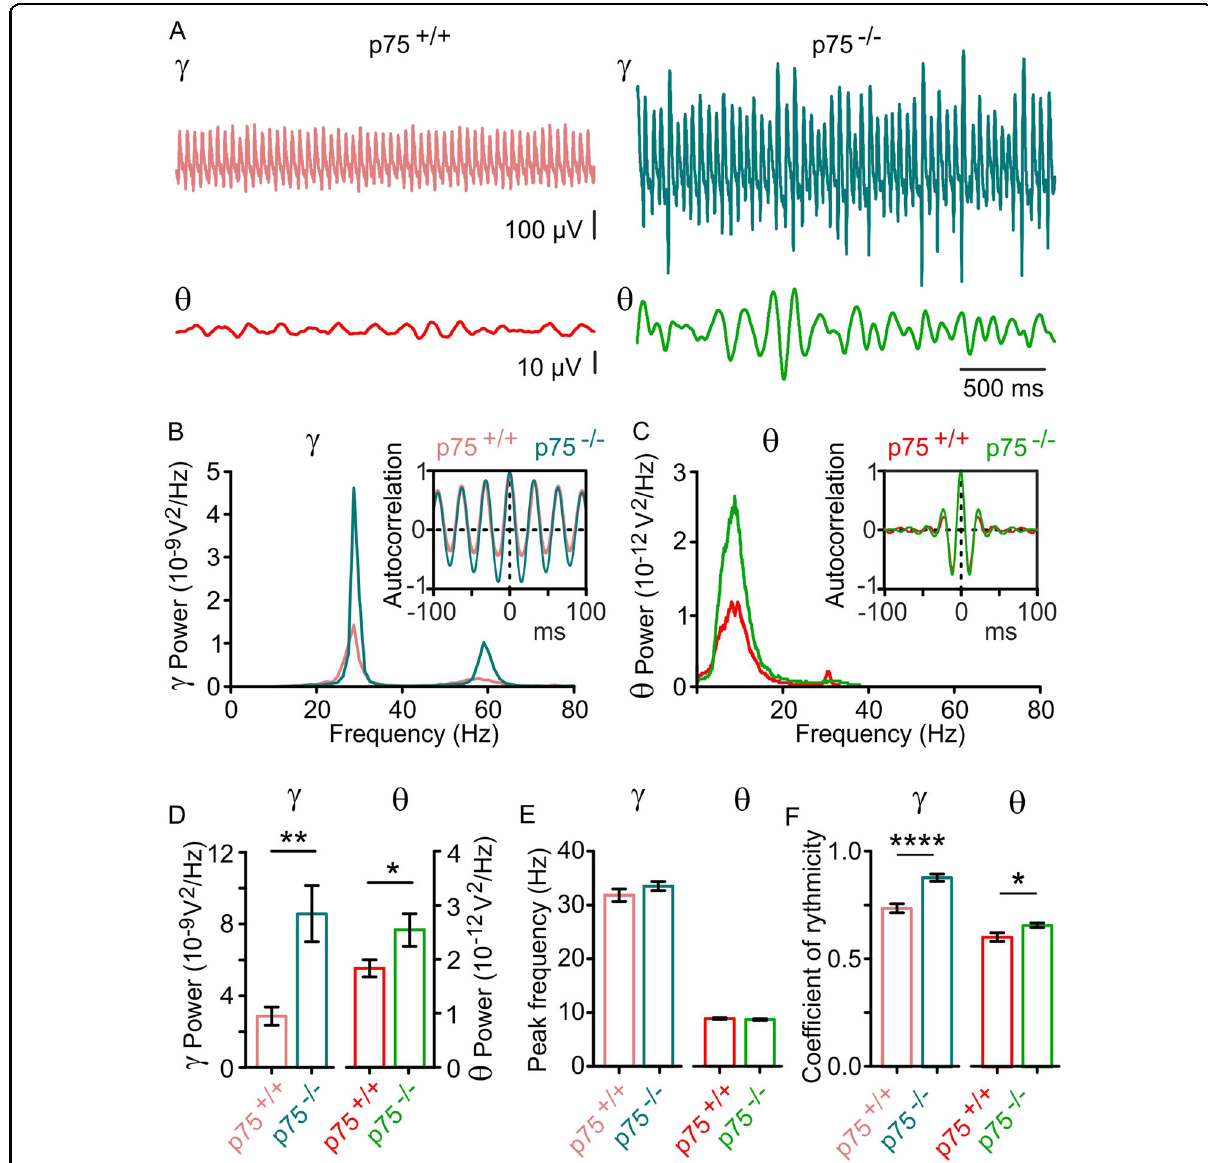
Fig. 4 p75 NTR ablation prevents A β -induced degradation of gamma oscillations. A Representative sample traces of CCh-induced gamma oscillations ( γ , upper traces) and the fi ltered theta component ( θ , lower traces) in A β -treated hippocampal slices from p75 + / + (red) and p75 − / − (green) mice 20 min after CCh bath application. B , C Representative power spectra of γ and θ oscillations recorded in the experimental conditions described in ( A ). Insets: Corresponding γ and θ oscillation autocorrelogram. Note that A β decreases γ and θ rhythmicity in p75 + / + mice compared to p75 − / − where rhythm quality remains unaltered. D Mean integrated power of γ oscillations (20 – 80 Hz) and fi ltered θ (4 – 10 Hz) from experiments described in ( A ), showing a signi fi cant degradation of γ and θ power induced by A β in p75 + / + mice (red). E Peak frequency of γ and θ spectra. F Coef fi cient of rhythmicity reveals a signi fi cant degradation of γ and θ rhythms recorded in p75 + / + mice, while A β failed to degrade rhythms in p75 − / − . Data are presented as mean ± SEM. * p < 0.05, *** p < 0.005, and **** p < 0.0001 compared to p75 + / +